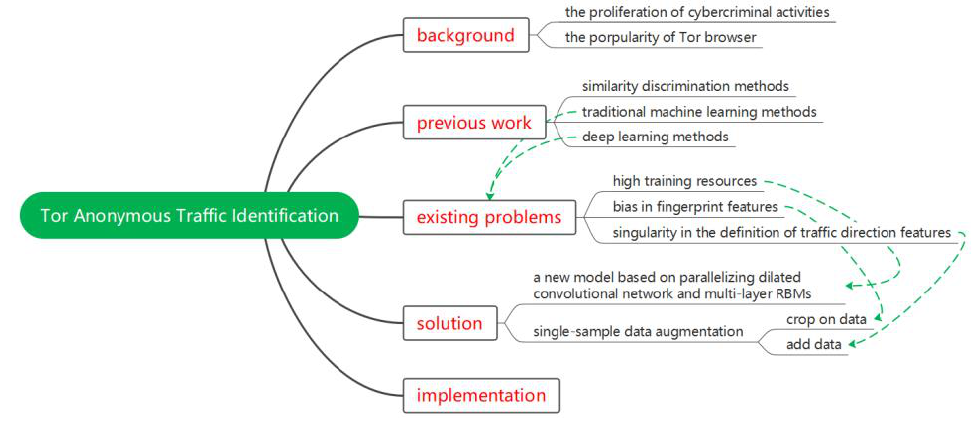
Figure 2. Mental map of the design.